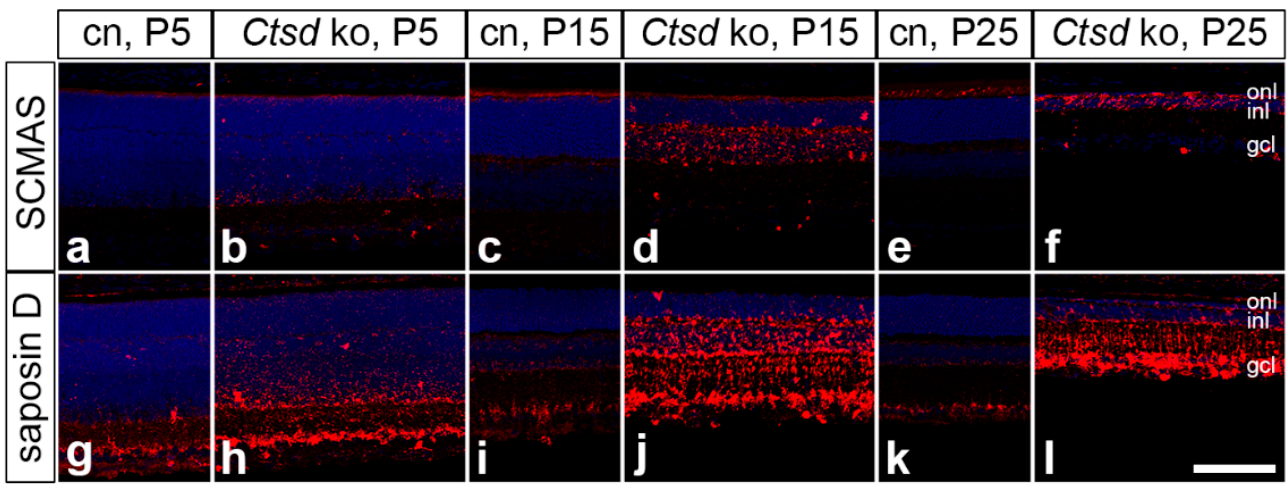
Figure 3. Accumulation of SCMAS and saposin D in Ctsd ko retinas. Levels of SCMAS and saposin D were moderately increased in P5 Ctsd ko retinas ( b , h , respectively) when compared with age-matched control mice ( a , g , respectively). A marked increase in SCMAS- and saposin D-immunoreactivity was observed in 15- ( d , j , respectively) and 25-day-old mutant retinas ( f , l , respectively) when compared to the corresponding control retinas ( c,e,i,k ). cn, control; gcl, ganglion cell layer; inl, inner nuclear layer; ko, knock-out; onl, outer nuclear layer; P, postnatal day; SCMAS, subunit c of mitochondrial ATP synthase. Scale bar: 100 µm.